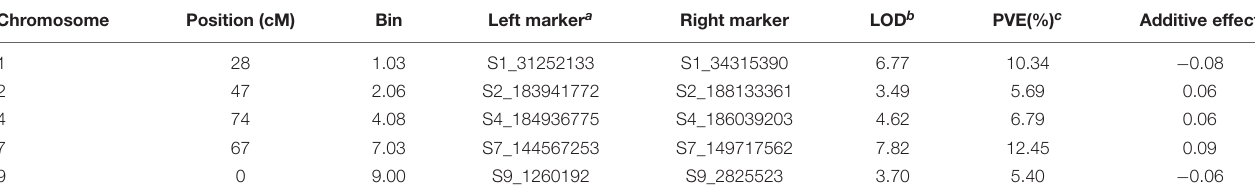
( Figure 3A ). The GP accuracy based on bin markers was 0.53 in DH1 ( Figure 3B ). No significant difference in